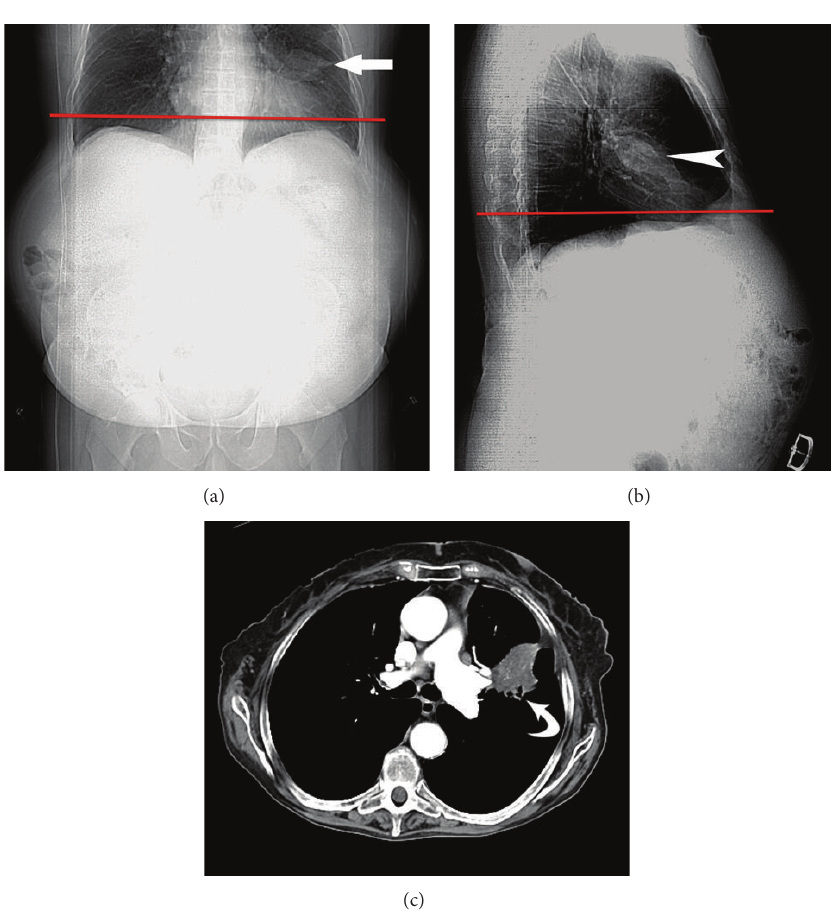
Figure 5: (a) AP and (b) lateral CT scout views demonstrate the lingular mass (arrow, arrowhead). The level of the first axial image from the colonic CT is shown by the red line, demonstrating that the scan commenced below the level of the lesion. (c) Axial chest CT section demonstrating the lingular mass (curved